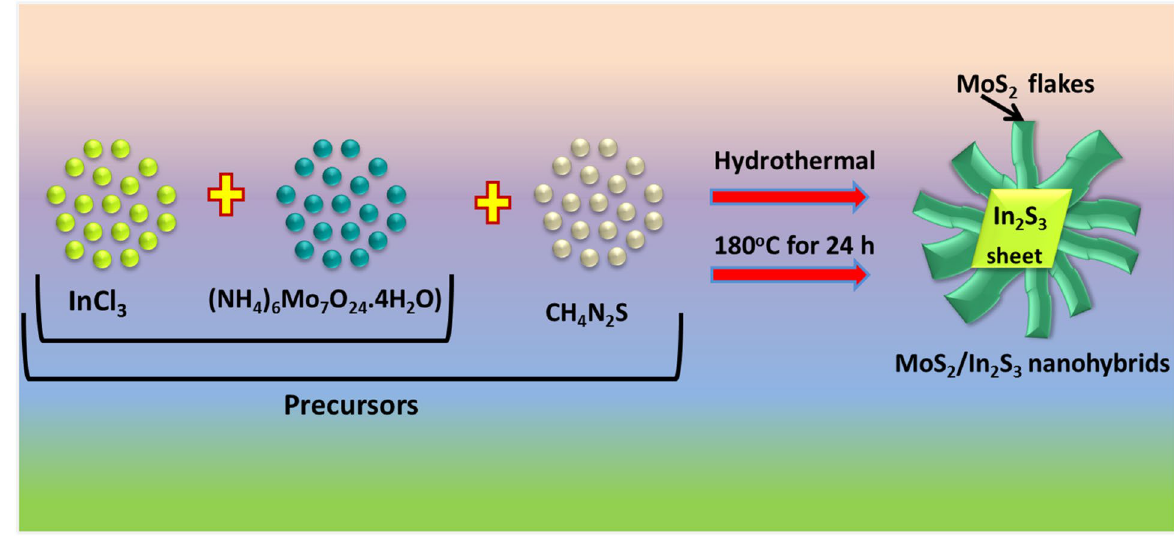
Figure 1. Depicts the fabrication process of In 2 S 3 –MoS 2